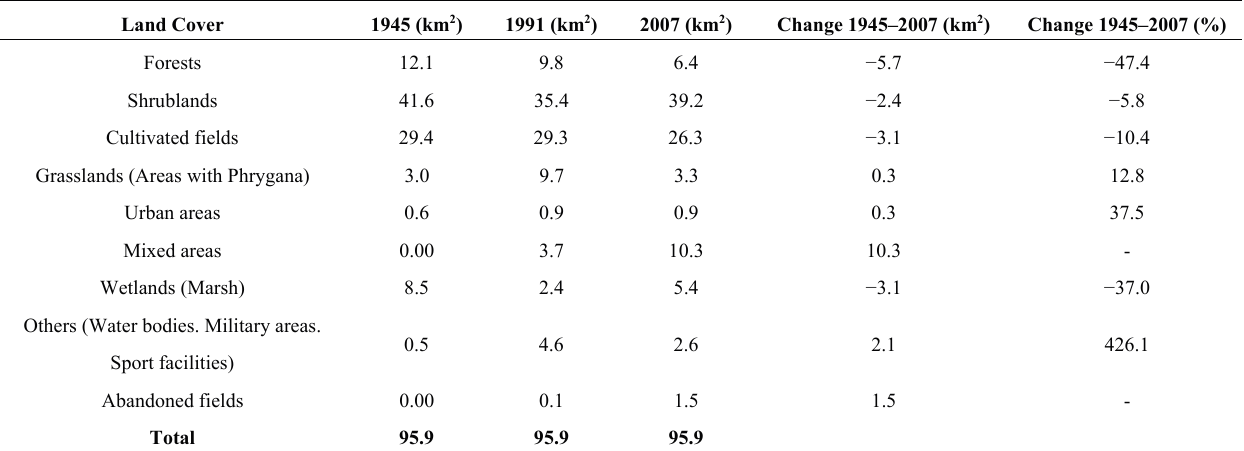
Table 4. Evolution of land cover classes between 1945, 1991 and